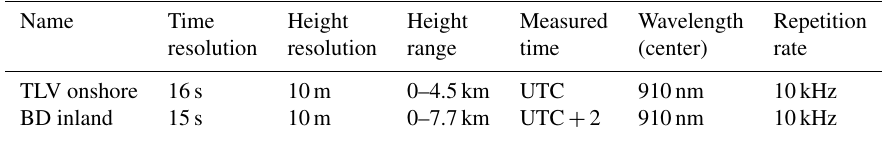
Table 1. Ceilometer CL31 parameters.